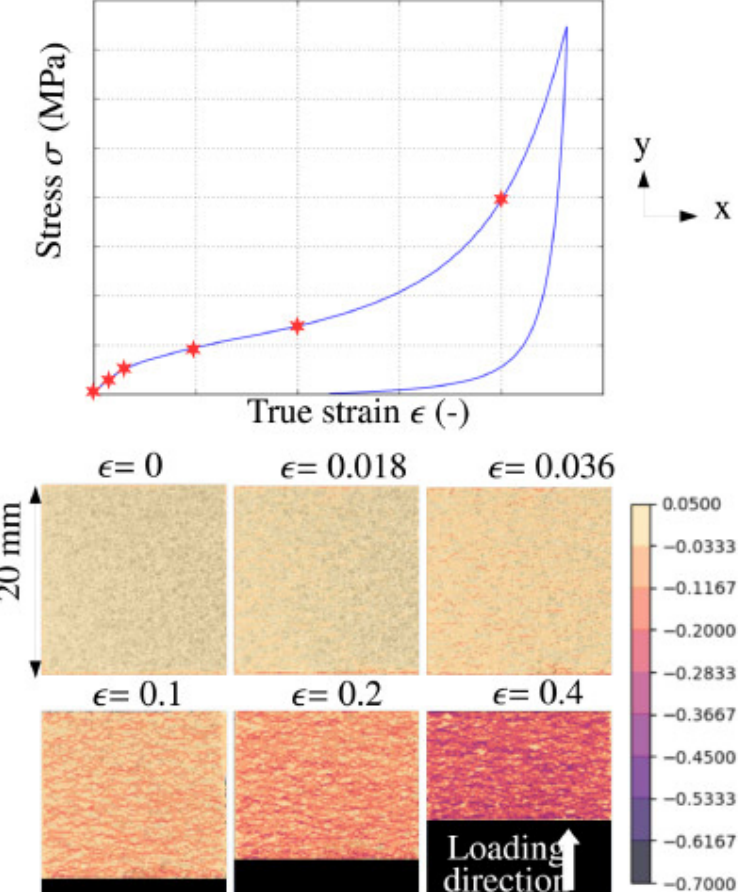
Figure 4. Longitudinal strain map at different moments of agglomerated cork compression (Reprinted with permission from [47]).